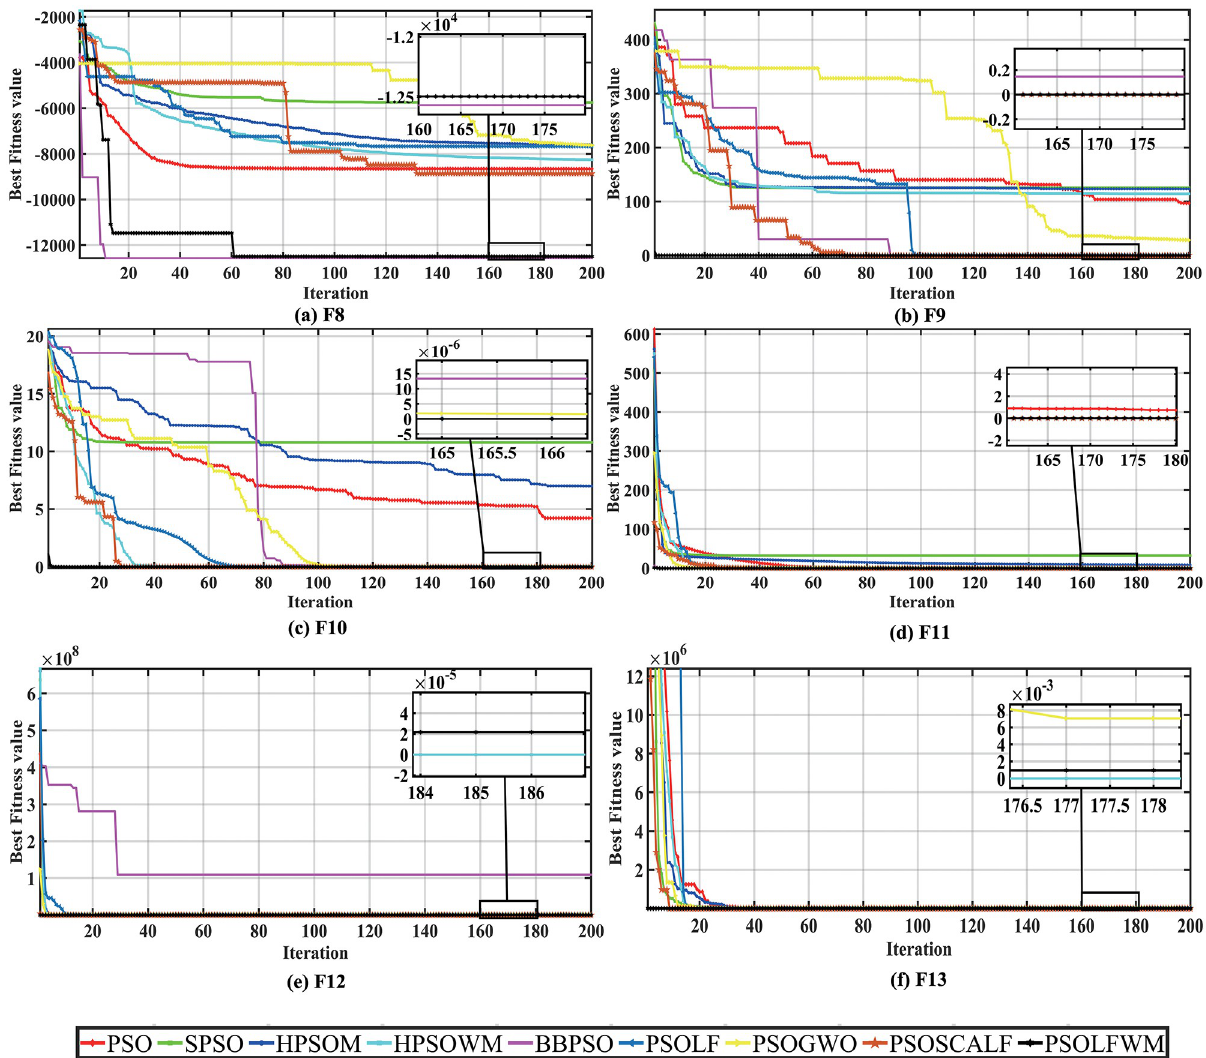
Fig 2. Convergence curve of multimodal functions compared with the PSO family algorithms. (a) F8, (b) F9, (c) F10, (d) F11, (e) F12, and (f) F13.